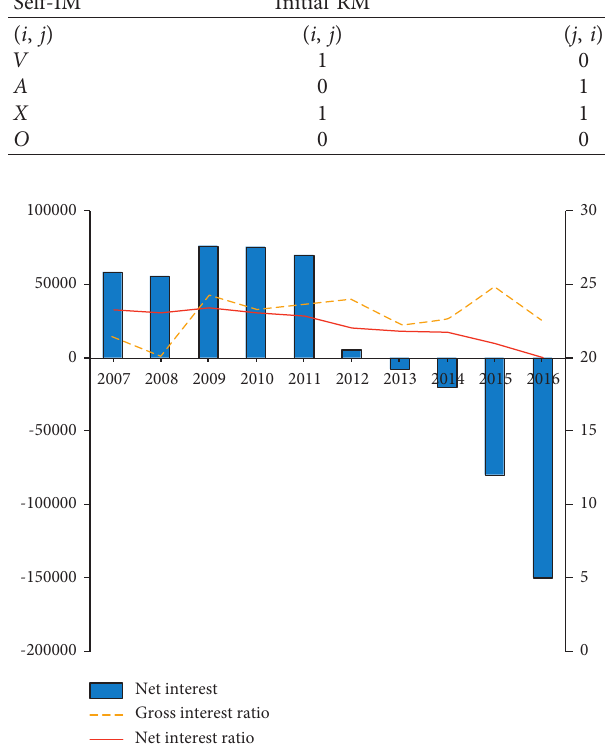
Figure 3: Net interest, gross interest rate and net interest rate of the Chinese machine tool industry from 2007 to 2016.